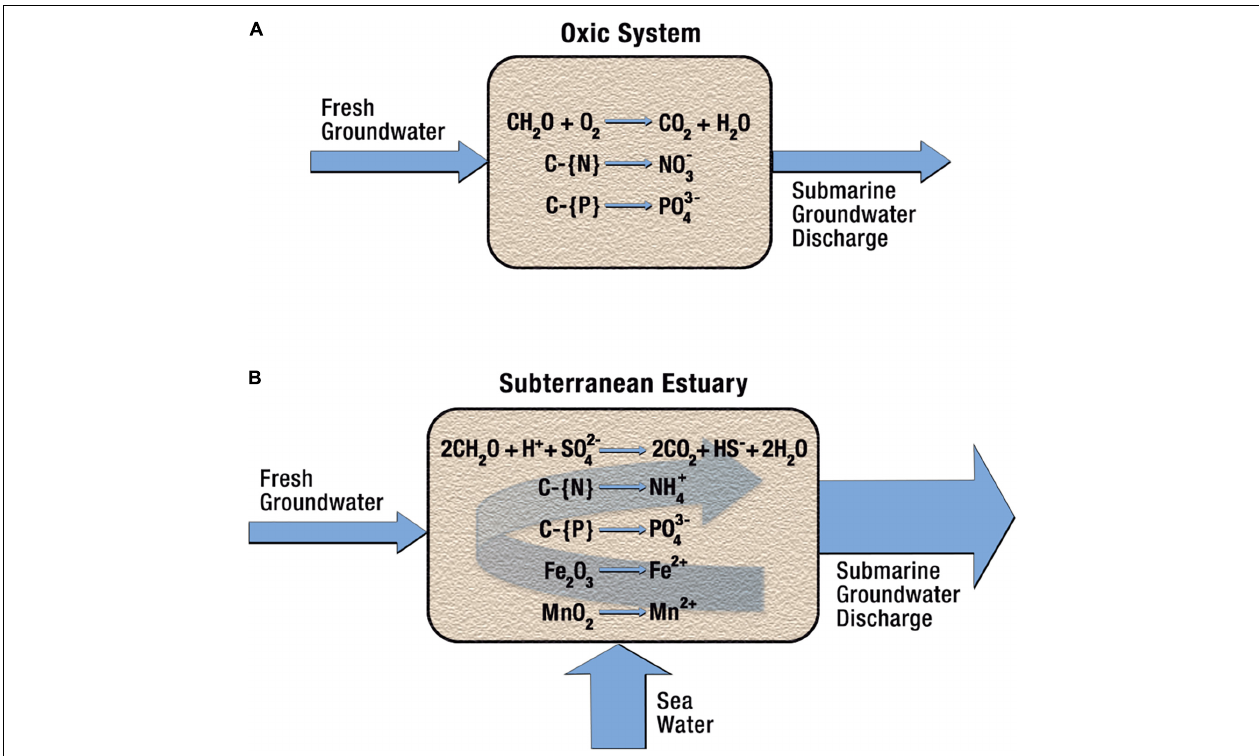
FIGURE 2 | Chemical differences between an oxic freshwater aquifer and an anoxic subterranean estuary. (A) As fresh oxygenated groundwater passes through an aquifer containing organic carbon, some carbon may be oxidized and release CO 2 as well as nitrate and phosphate ions. The maximum concentration of nitrate produced ( ∼ 42 µ M) is controlled by the solubility of oxygen ( ∼ 0.28 mM) and the C:N ratio of the organic matter ( ∼ 6.6 for marine organic matter). (B) The addition of saltwater to this system greatly increases the oxidizing capacity after O 2 is exhausted due to sulfate ion ( ∼ 28 mM in ocean water). Here the reaction products include significantly greater concentrations of CO 2 , ammonium and phosphate as well as sulfide, which can reduce metal oxides, liberating Fe 2 + and Mn 2 + and other metals and non-metals to